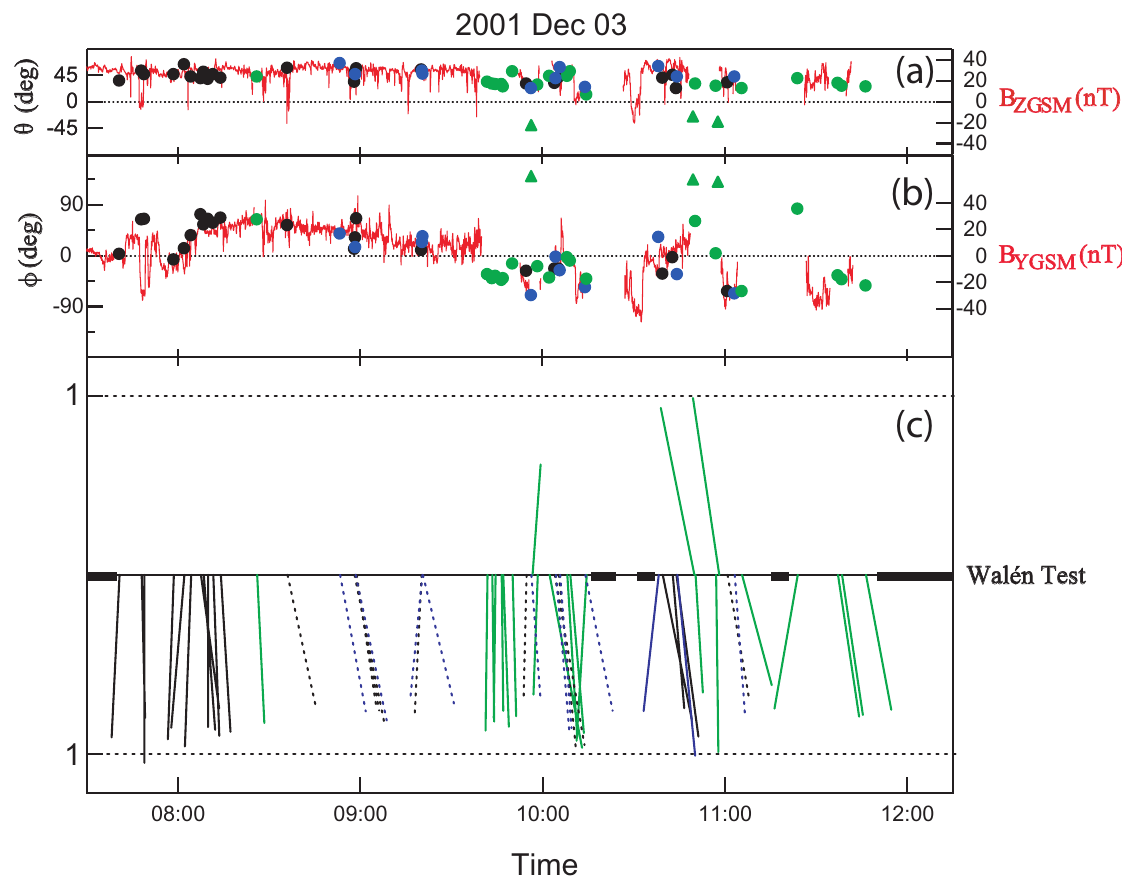
Fig. 6. Wal´en test and direction of the reconnection jets. (a) Superposed latitude θ GSM and SC/3 B Z GSM , (b) superposed longitude φ GSM and SC/3 B Y GSM , (c) temporal history of the Wal´en test during the event. Sunward flows are indicated by circles while antisunward flows by triangles. SC/1 data are in black, SC/3 data in green, SC/4 data in blue. Reconnection jets associated with complete/partial crossings are indicated by full/dashed lines. A perfect Wal´en test would give a vertical vector of unit length, pointing up (down) for antisunward (sunward) flows. Horizontal black bars indicate intervals when all the SCs are far from the